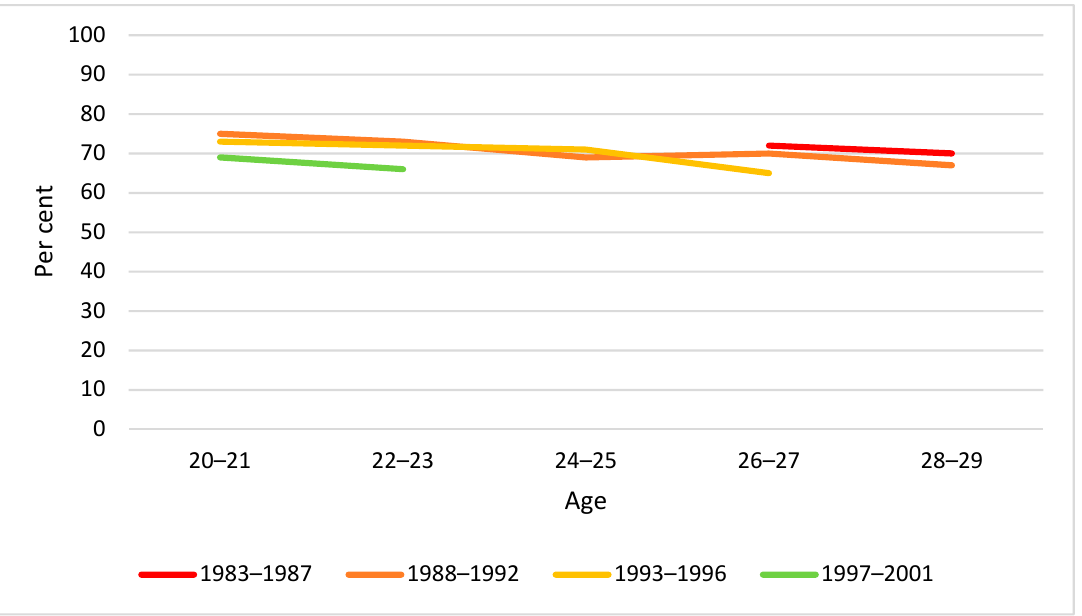
Figure 3. Proportion monthly drinking by birth cohort and age. Note: None of the cohort differences at any age were statistically significant ( p > 0.05).